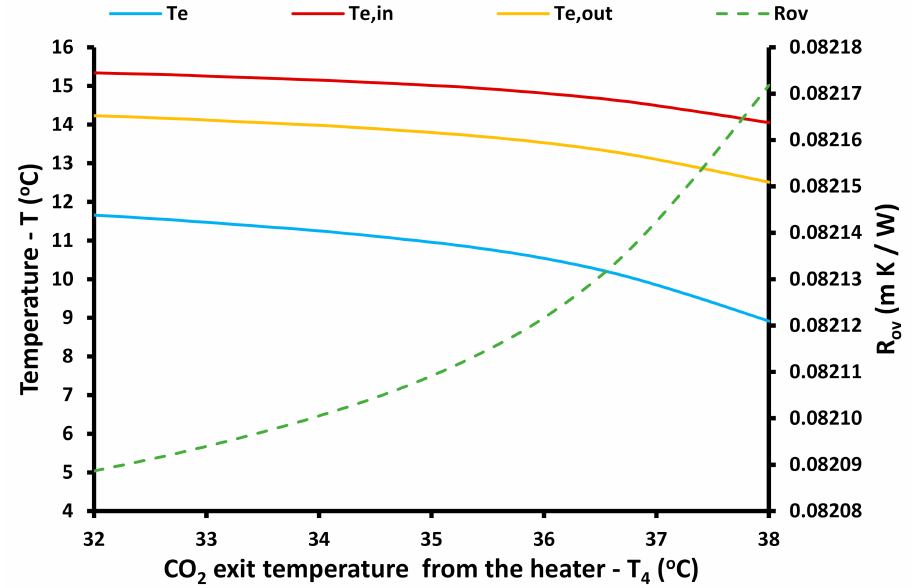
Figure 9. The impact of the CO 2 exit temperature from the heater on the evaporator temperature levels and on the overall resistance.